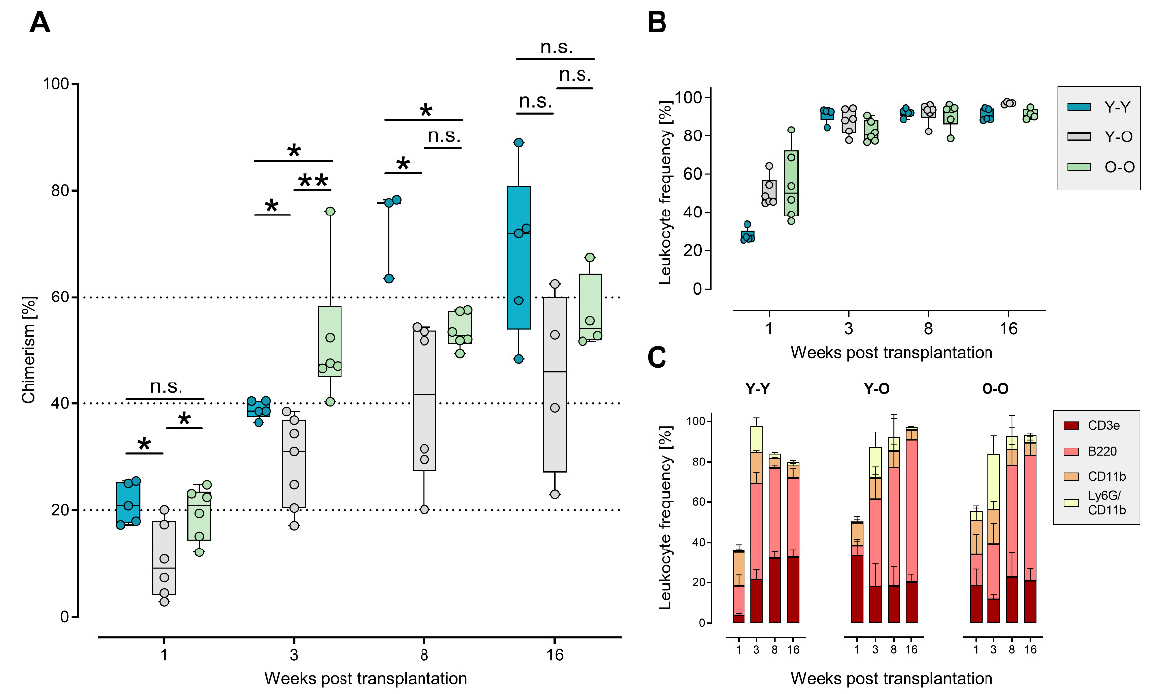
Figure 2. Reconstitution dynamics. ( A ) We determined the chimerism via a Y chromosome-specific ddPCR in the bone marrow of transplanted animals. The pair-wised Mann–Whitney U-Test showed some statistical significance in reconstitution dynamics between the three groups, despite great inter-animal variances. Non-adjusted p-values are indicated as not significant (n.s.) for p > 0.05, * for p < 0.05, and ** for p < 0.01. Blue bars represent the Y-Y experimental setting ( n = 3–5), grey bars represent the Y-O experimental setting ( n = 4–7), and light green bars the O-O experimental setting ( n = 4–6). ( B , C ) We followed leukocyte reconstitution in the spleen for all leukocytes (in B ) and specifically for the respective subpopulations, i.e., T cells (CD3e), B cells (B220), monocytes/macrophages (CD11b), and granulocytes (CD11b and Ly6G) (in C ). The frequencies of these populations after transplantation were similar, independent of the age of the donor mice (Y-Y and Y-O vs. O-O).